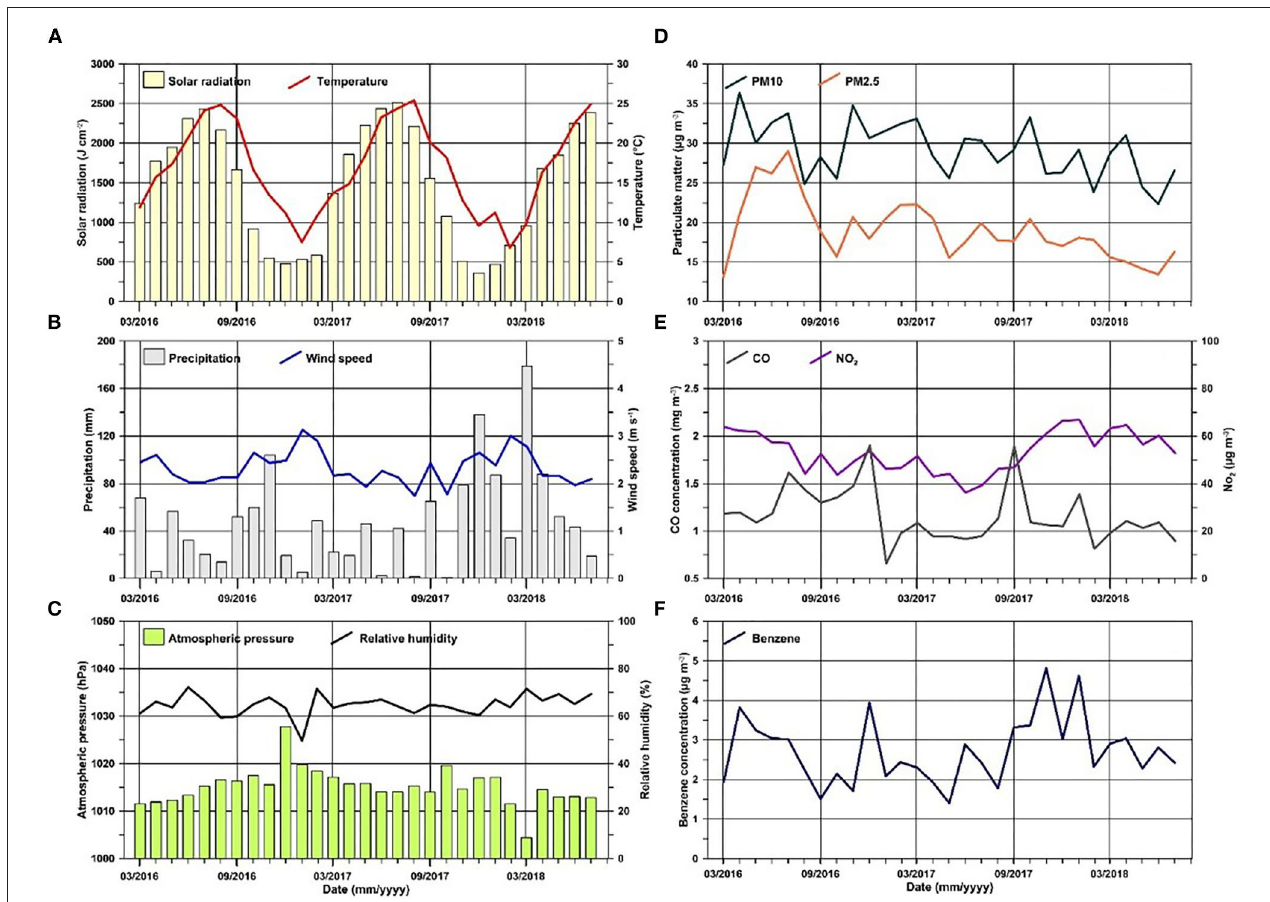
FIGURE 1 | Monthly distribution of (A) solar radiation (pale yellow bars) and temperature (red line); (B) precipitation (gray bars) and wind speed (blue line); (C) atmospheric pressure (green bars) and relative humidity (black line); (D) particulate matter concentrations (PM 10 -dark green line and PM 2.5 -orange line); (E) CO (gray line) and NO 2 (violet line) concentrations; (F) benzene concentrations (dark blue